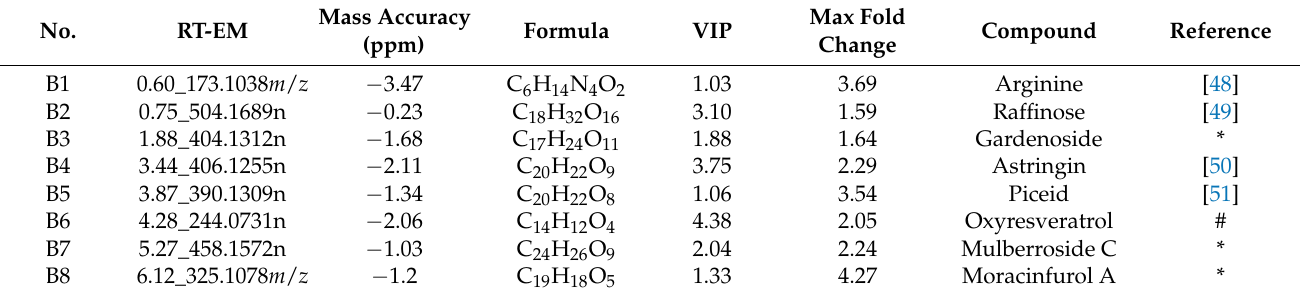
Table 2. Differential metabolites for male and female stem barks, filtered with VIP > 1, | p | ≥ 0.05 and | p (corr)| ≥ 0.5, ANOVA p value ≤ 0.05, and max fold change ≥